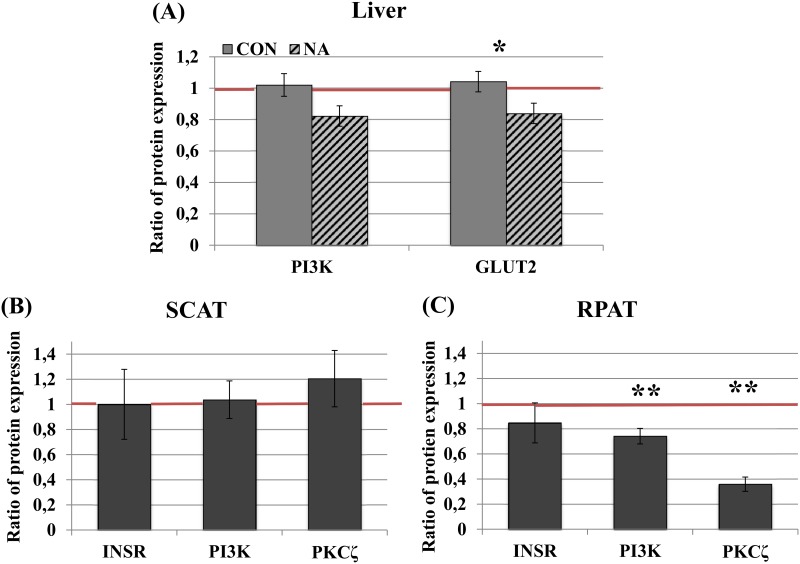
Hepatic protein expression as affected by NA and adipose protein expression as affected by time.A: The ratios of pooled groups (pool “NA” = HC-NA, LC-NA and pool “CON” = HC-CON, LC-CON, 24 or 0 g/d nicotinic acid from d1 to d21) were tested for the influence of nicotinic acid supplementation on the hepatic protein expression of PI3K and GLUT2 by one-way ANOVA (n = 10/group). Hepatic GLUT2 expression decreased from d-21 to d21 (ratio < 1) in cows fed NA, and it was lower in cows fed NA (*p = 0.03) compared to control cows at d21. B, C: The ratios of the protein expression in subcutaneous (B, “SCAT”) and retroperitoneal (C, “RPAT”) adipose tissue from all the cows. Cows were pooled (HC-NA, LC-NA, HC-CON, LC-CON) and tested for the difference to 1 by one-sample t-test (n = 20). The expression of signaling proteins in RPAT was generally lower at d21 compared to at d-21 (ratio < 1; **p < 0.01). Ratio = protein expression d21/d-21; ratio > 1: increase, ratio < 1: decrease; The red line indicates the ratio of protein expression at d-21 (d-21/d-21 = 1). Data are shown as mean ± standard error. NA: nicotinic acid, PI3K: phosphatidylinositol-3-kinase, GLUT2: glucose transporter 2, INSR: insulin receptor, PKCζ = protein kinase Cζ.